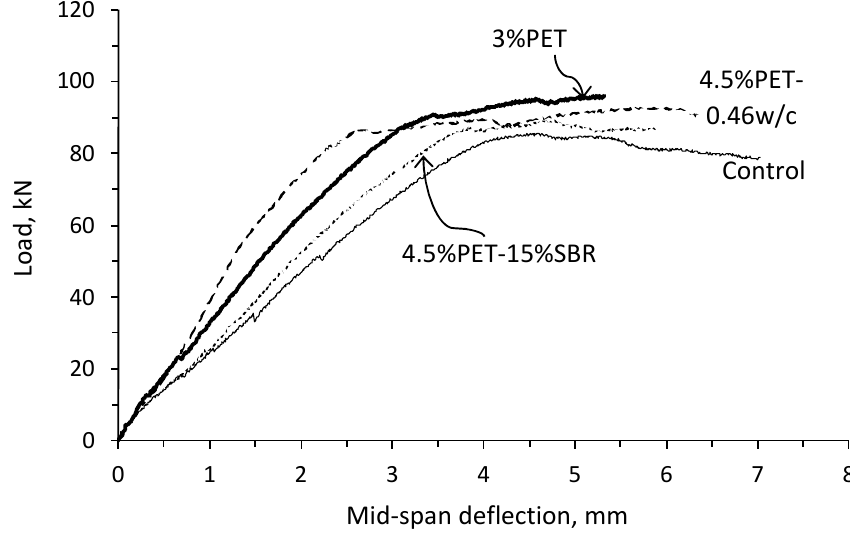
Figure 5. Load vs. mid-span deflection curves for RC beams (i.e., flexure testing).